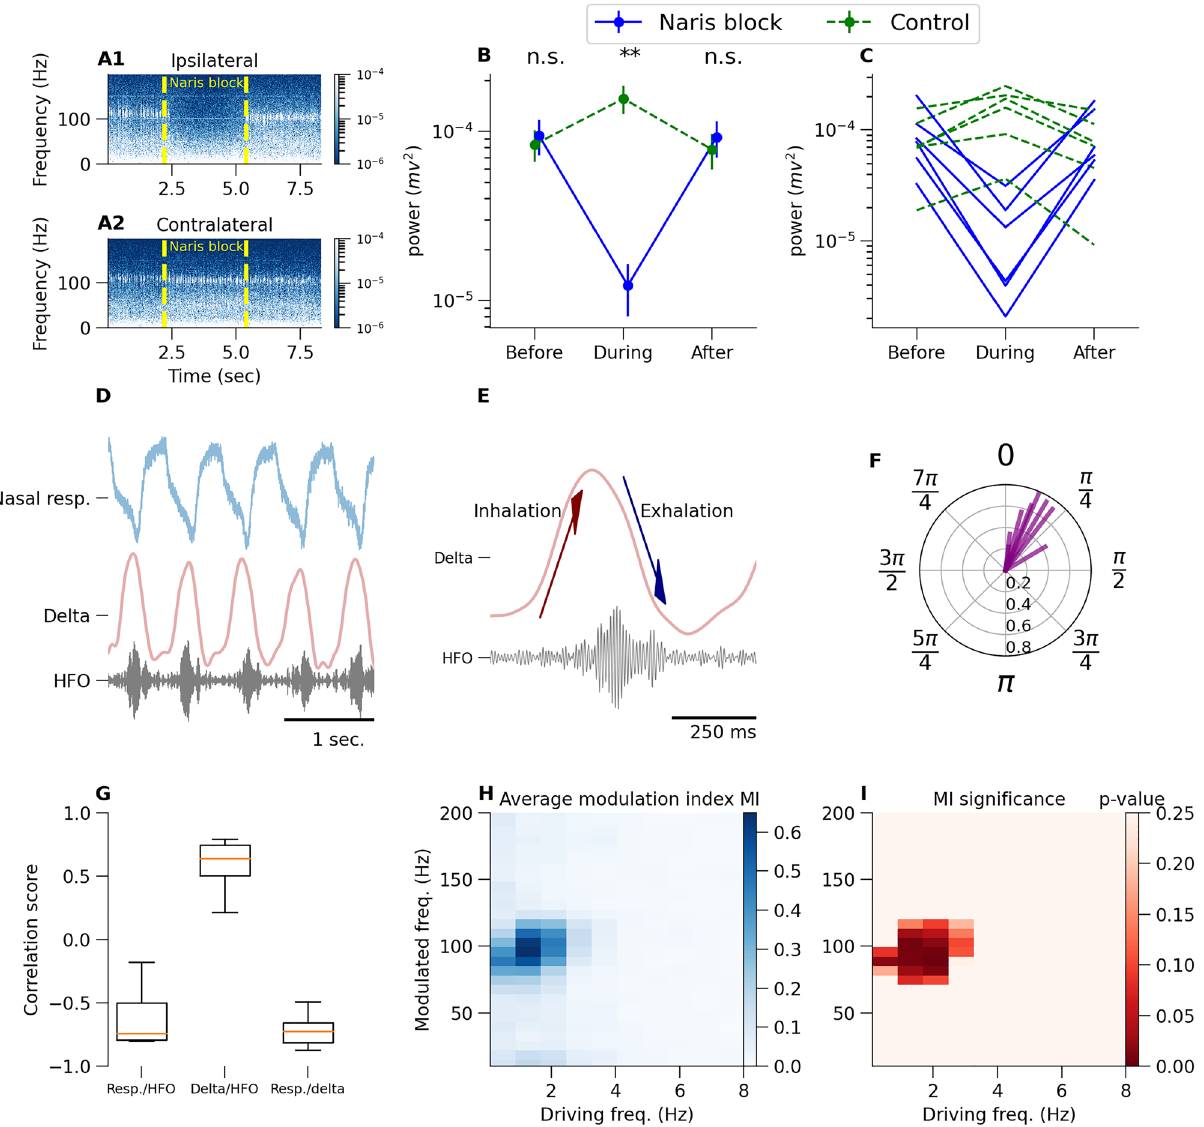
Figure 2. Nasal respiration modulates KX-dependent 80–130 Hz oscillations in the OB of anesthetized rats. ( A ) Spectrogram computed from ipsilateral and contralateral to the naris blockade OB channels. Dotted lines relate to naris blockade time. ( B ) Extracted data from spectrogram of power of dominant frequency in 80–130 Hz range (average across rats n = 8). Unilateral naris blockade reduced 80–130 Hz power on the ipsilateral side but increased 80–130 Hz power contralateral to blockade. Values from individual rats are shown in ( C ). ( D ) Simultaneous OB LFP and respiratory rhythm recorded using thermocouples. ( E ) Example recordings of simultaneous OB LFP for delta (0.3–3 Hz) and the 80–130 Hz rhythm. Arrows show respiratory cycle phase. ( F ) Phase plot of the peak of the burst of KX 80–130 Hz activity relative to delta peak (phase zero). Each radius represents ITPC (see "Methods") of one rat. ( G ) Waveform correlation scores calculated for 5 min for respiration rhythm and OB LFP delta (first box plot), delta and the envelope of 80–130 activity (second box plot), and respiration rhythm and OB LFP delta (third box plot). Box plots show first to third quartile of the correlation scores, median (orange line) and all data range of n = 8 rats (error bars). ( H ) Modulation index matrix (averaged across rats n = 8) for 5 min of continuous LFP signal under KX anesthesia. ( I ) Resampling (across rats) statistics for modulation index “pixels”. Control group for resampling were rats under isoflurane anesthesia (**p<0.01 and n.s. (not significant) with respect to